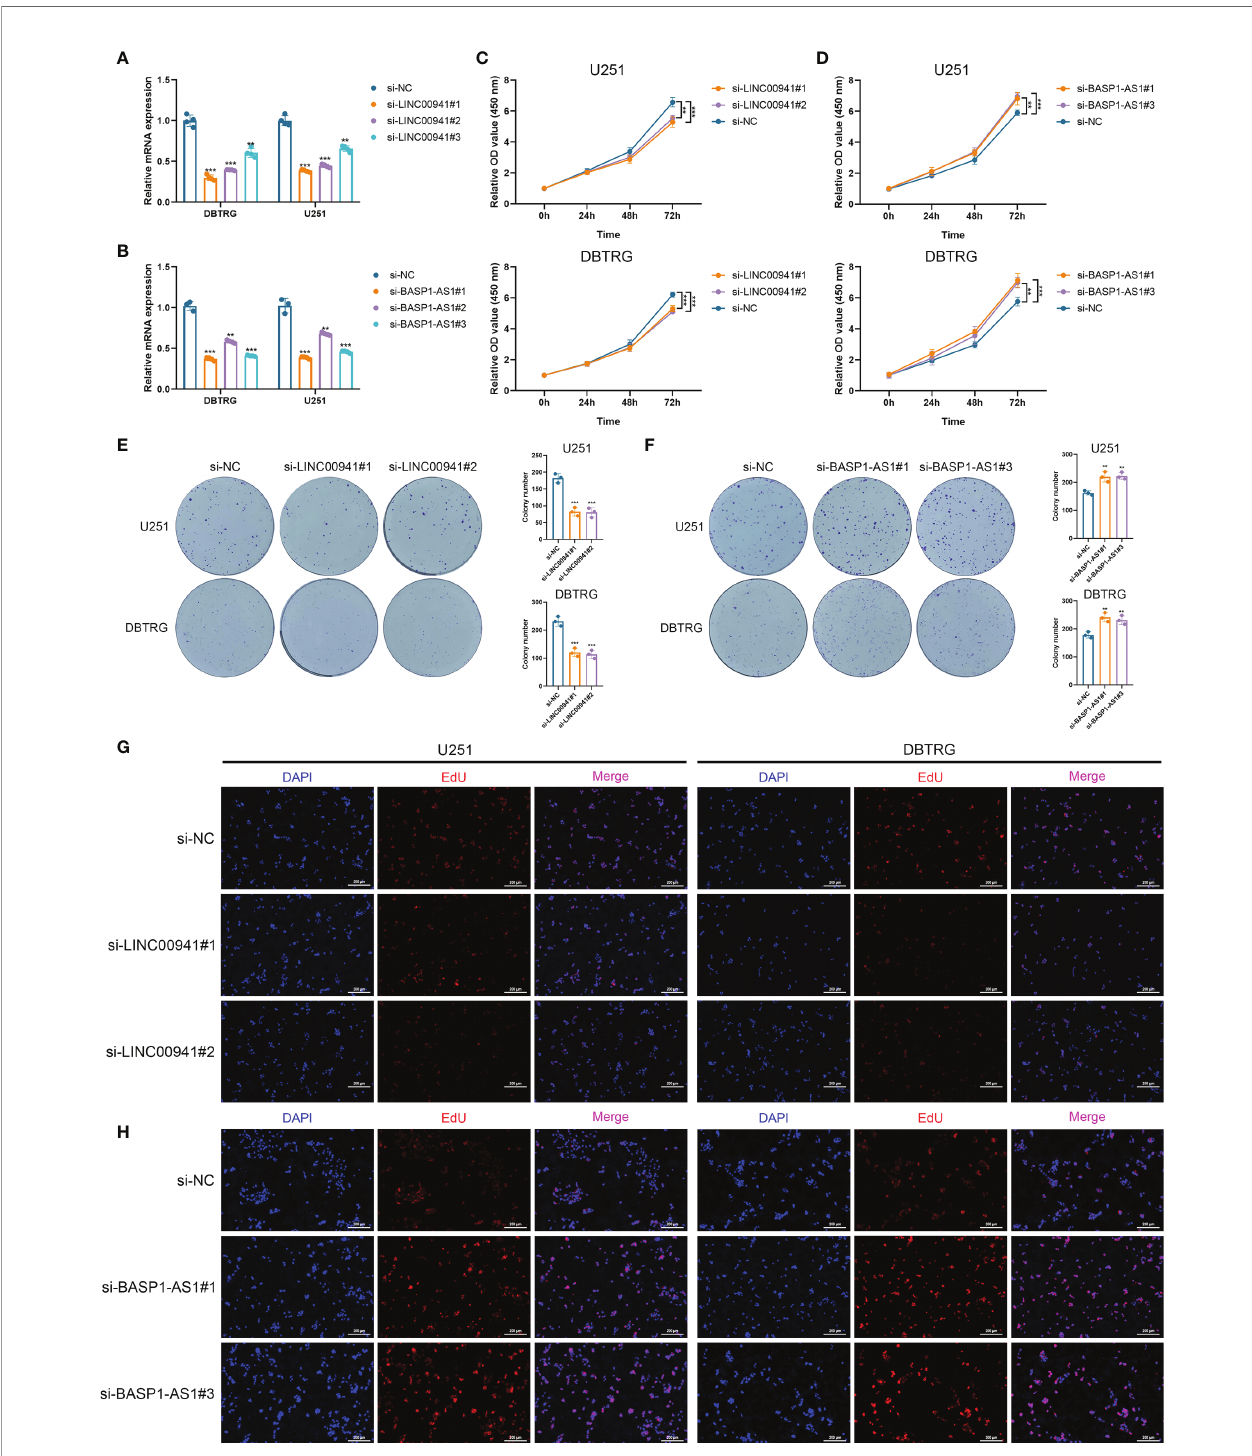
FIGURE 8 | LINC00941 and BASP1-AS1 exerted opposite effects on the proliferation of glioma cells. (A, B) The expression of LINC00941 (A) and BASP1-AS1 (B) after the transfection of three speci fi c siRNAs. (C, D) CCK-8 assay of U251 and DBTRG cells after the knockdown of LINC00941 (C) and BASP1-AS1 (D) . (E, F) Colony formation assay of U251 and DBTRG cells after the knockdown of LINC00941 (E) and BASP1-AS1 (F) . (G, H) EdU assay of U251 and DBTRG cells after the knockdown of LINC00941 (G) and BASP1-AS1 (H) . **p < 0.01, ***p <